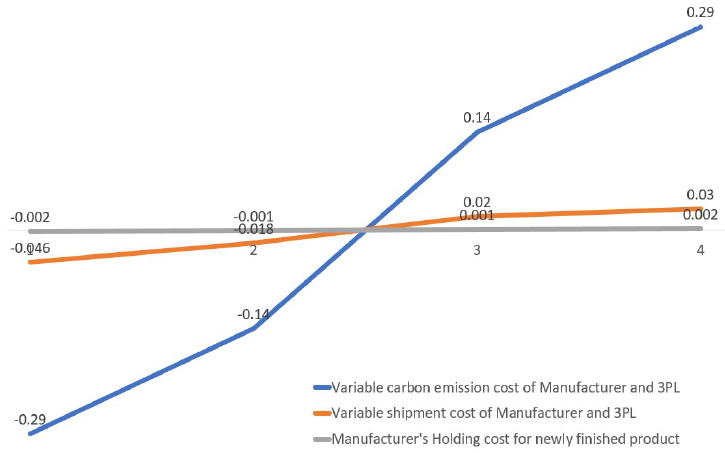
Figure 7. Effect of changes of total cost for changes of various parameters.